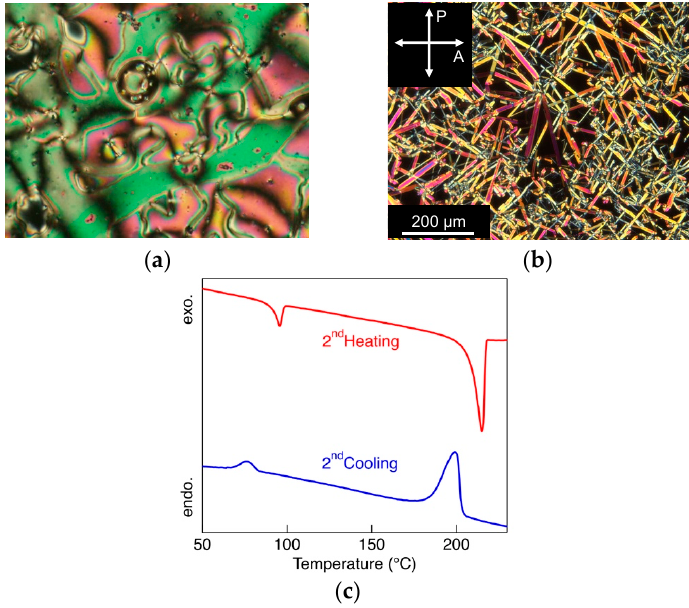
Figure 4. Polarizing optical micrographs of Au complexes 1 and 3b under crossed polarizers: ( a ) 1 at 78 °C in the 1st cooling process (N phase); ( b ) 3b at 200 °C in the 2nd cooling process (SmA phase). White arrows show the direction of polarizers. ( c ) Differential scanning calorimetry (DSC) thermograms of complexes 3b . Scanning rate: 2.0 °C min –1 .